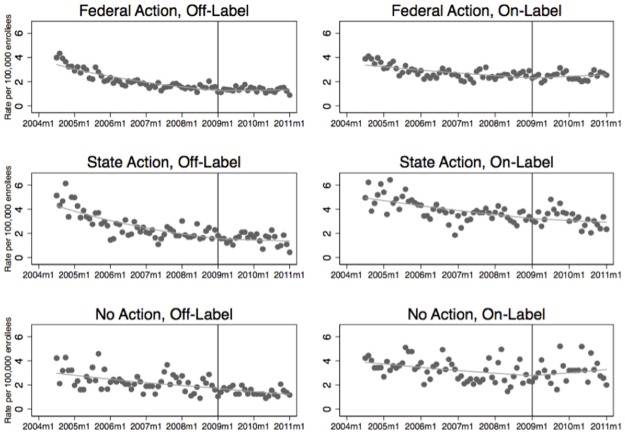
Time-series analysis of new adult users of olanzapine for on- and off-label indications before and after federal settlement under the False Claims Act, with states grouped by type of investigation pursued against the manufacturer, July 2004 through January 2011.The first time interval included the 54 months from July 2004 through December 2008. The US Department of Justice announced the federal False Claims Act settlement with Lilly in January 2009, which served as the breakpoint for our analysis. The second time period spanned the 24 months from February 2009 through January 2011.